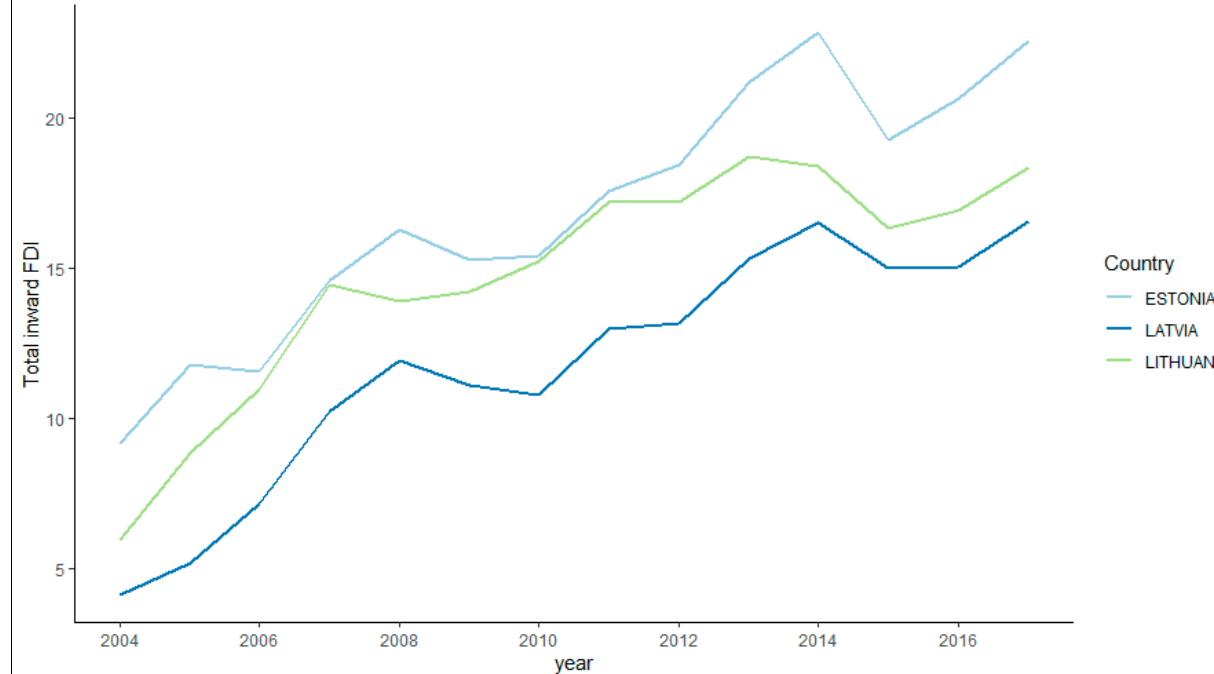
Figure A7. Inward FDI stocks in Estonia, Latvia, and Lithuania across 2004–2017 (current USD billion). Source: Bank